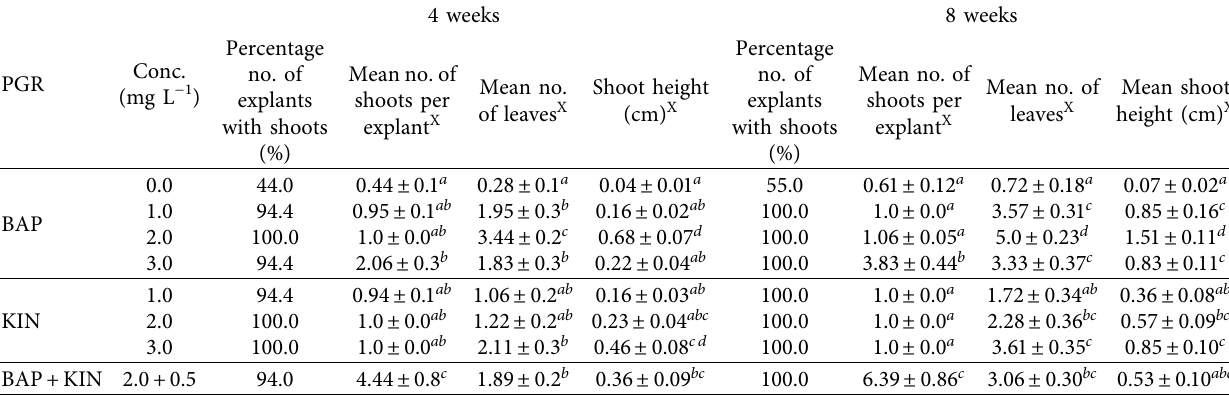
Table 2: Effect of BAP and KIN on shoot multiplication of nodal explants of KPF 4 variety of passion fruit after 4 and 8 weeks of culture.